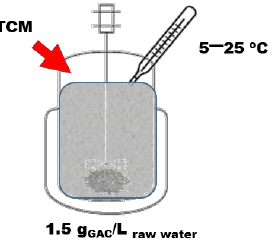
Figure 2. Reactor used for adsorption assay on GAC.